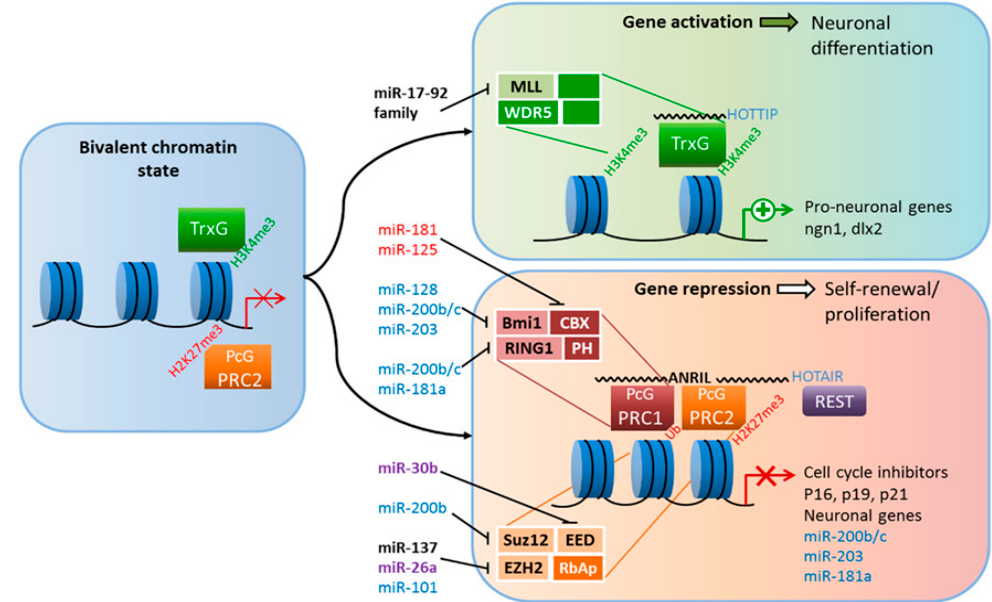
Figure 3. Role of the polycomb group protein complex and the trithorax protein complex in neurogenesis. The trithorax complex (TrxG) is associated with the activation of histone, leading to neuronal differentiation, while the polycomb complex (PcG) is associated with repressive histones, leading to decreased proliferation (adopted from [68]).